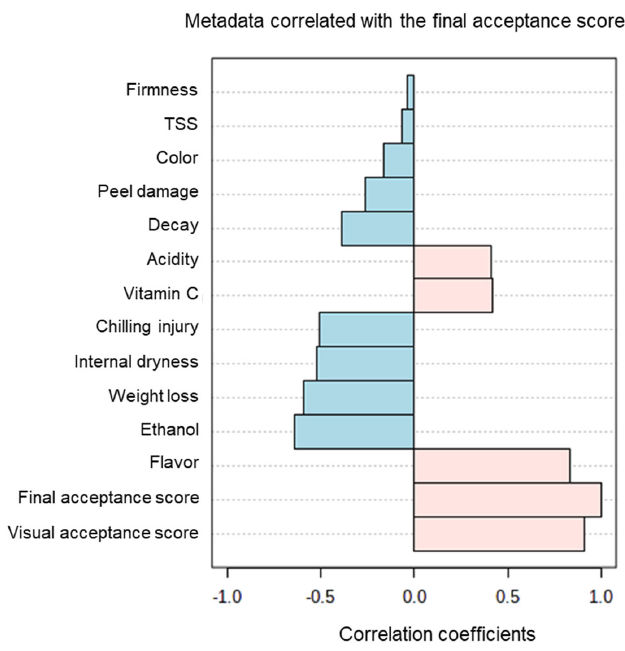
Figure 7. Pearson correlations between the various fruit-quality parameters and the final acceptance scores.